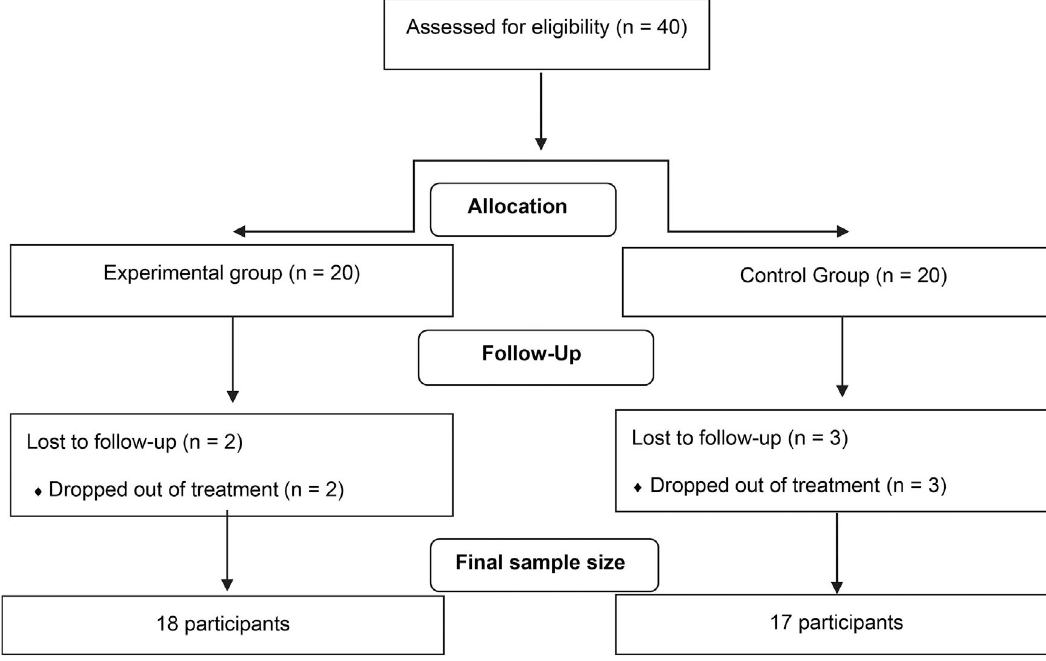
Figure 1 - Flowchart describing the study sample and distribution